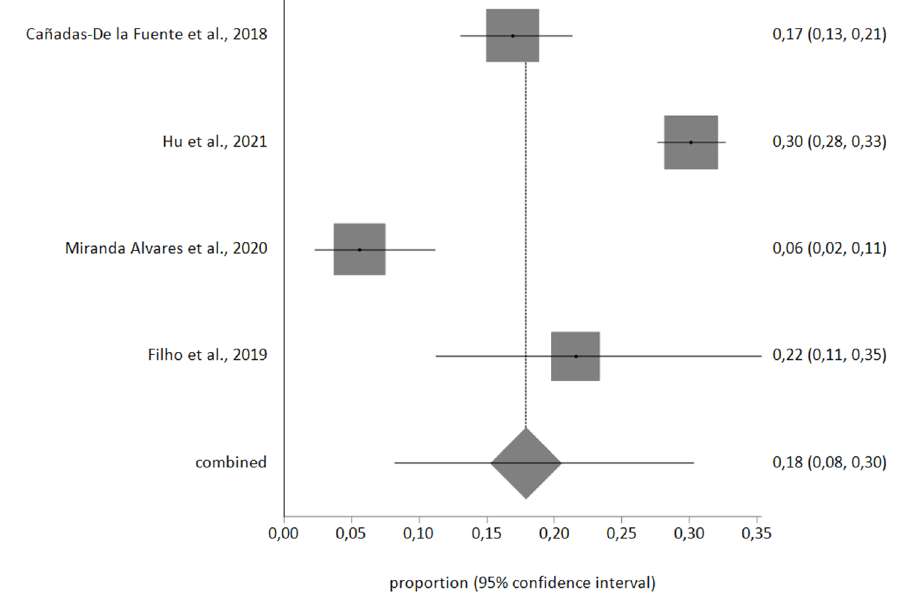
Figure 3. High D forest plot.